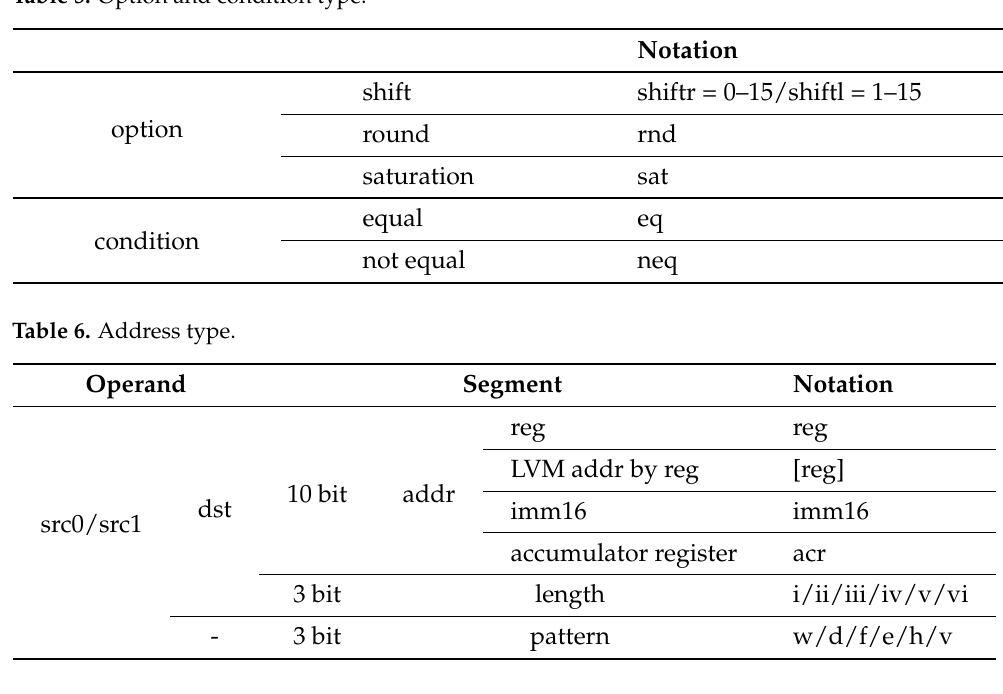
Table 5. Option and condition type.